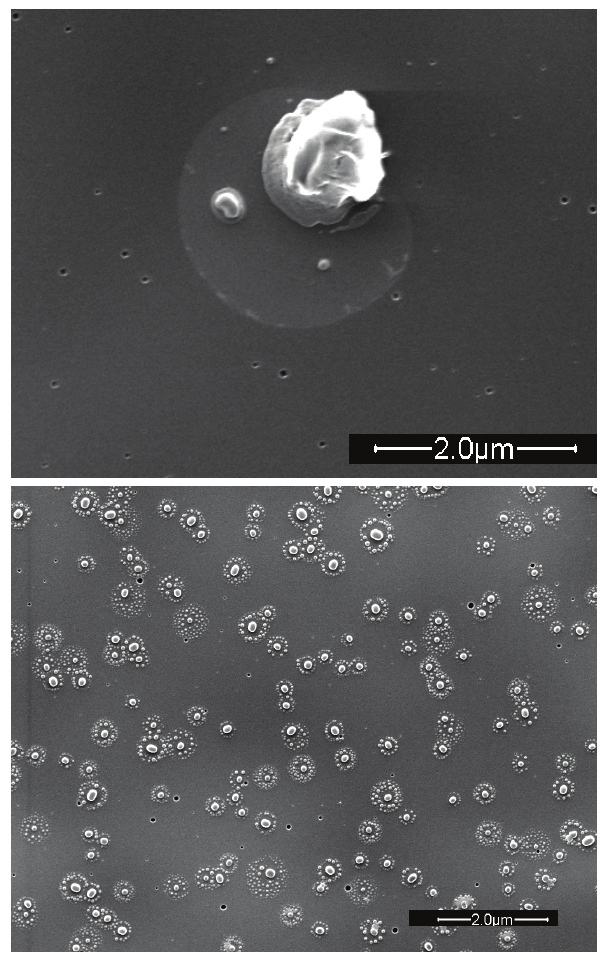
Figure 6. SEM images of aerosol particles in (a) coarse mode and (b) fine mode.